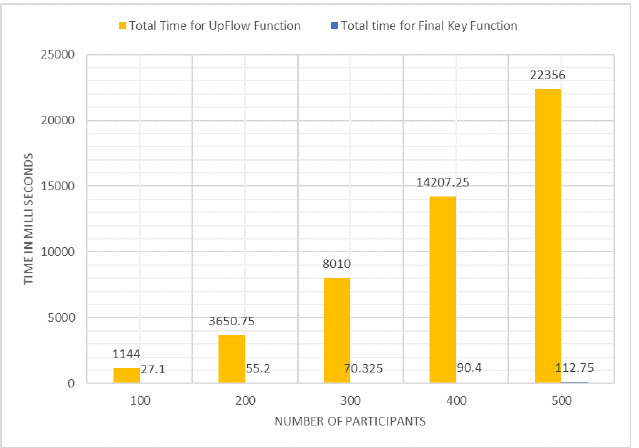
Figure 7. Graph showing a comparison of the upflow function alongside the final key generation function.